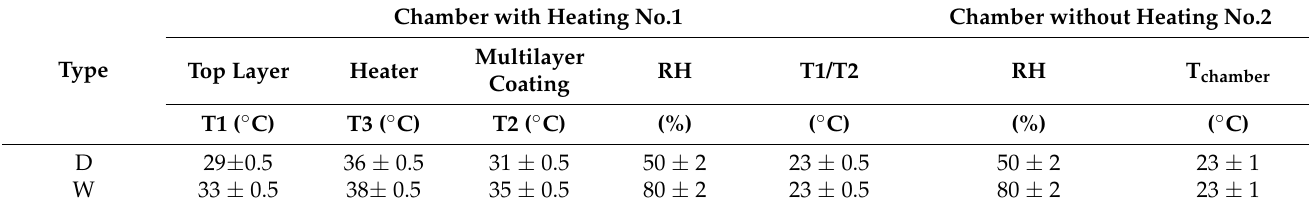
Table 4. Test parameters fixed values and accuracy of measurement.